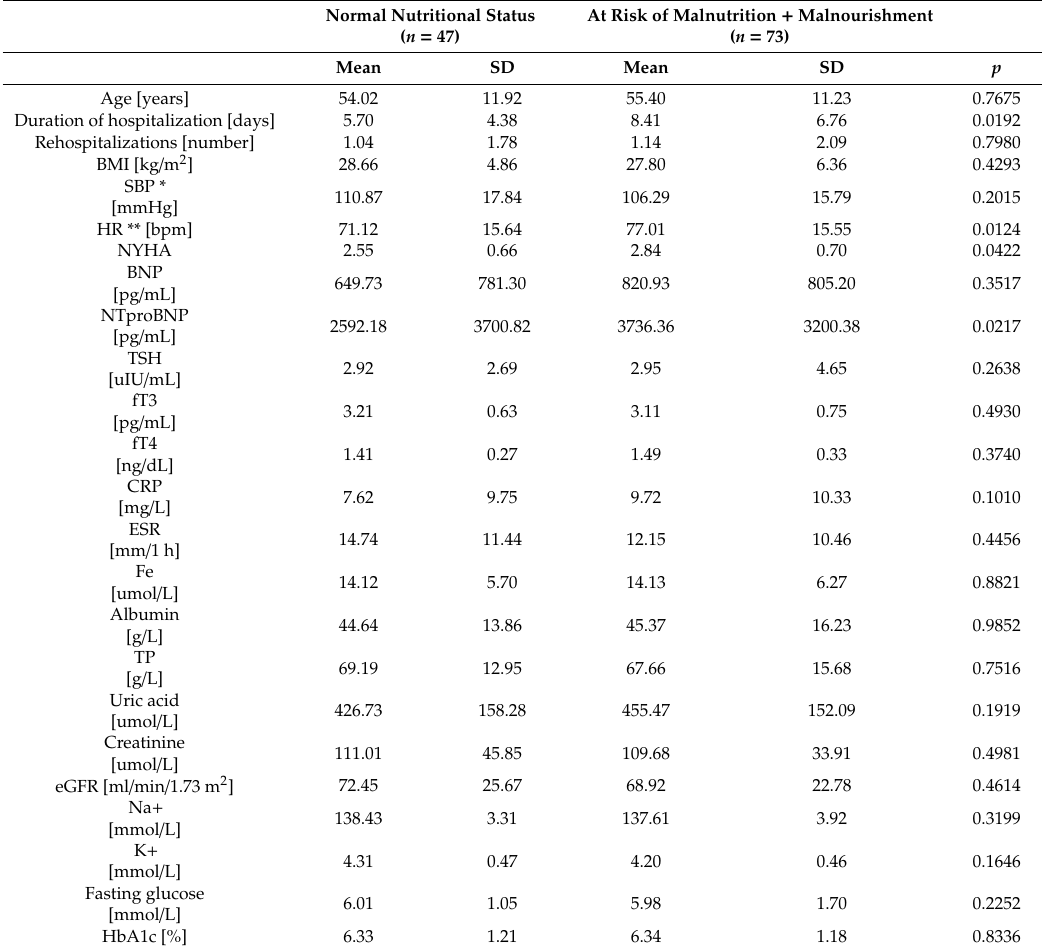
Table 3. Di ff erences between the patients with normal nutritional status and the combined groups of malnourished patients and those at risk of